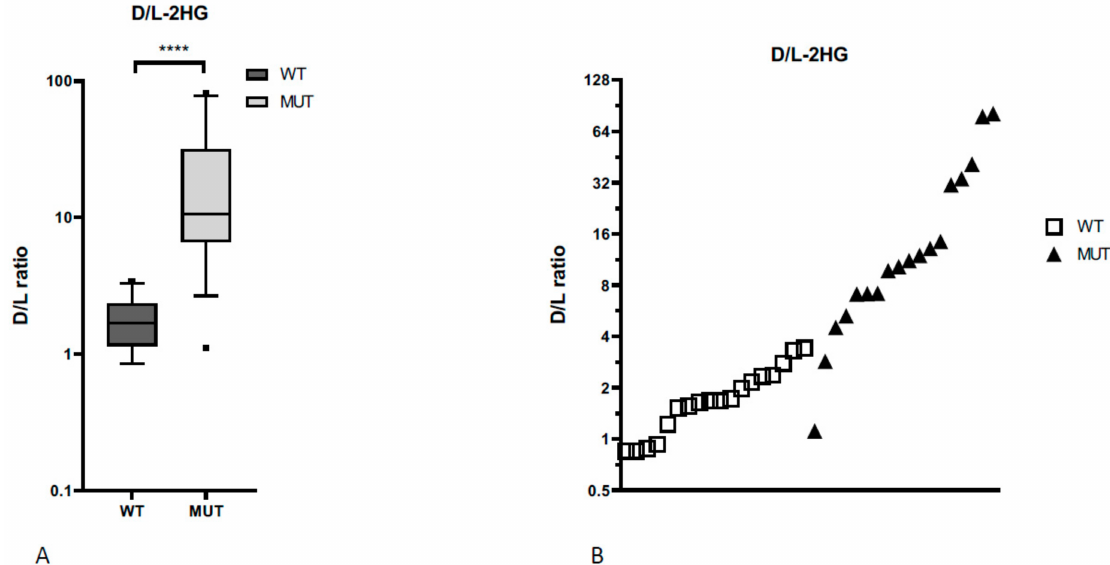
Figure 4. The D/L -2HG ratio ( A ) was significantly higher in patients with an IDH1 mutation compared to patients without an IDH1 mutation (**** p < 0.0001, two-way Mann–Whitney test). ( B ) The optimal cutoff value of 4.5 for the presence of an IDH1 mutation is